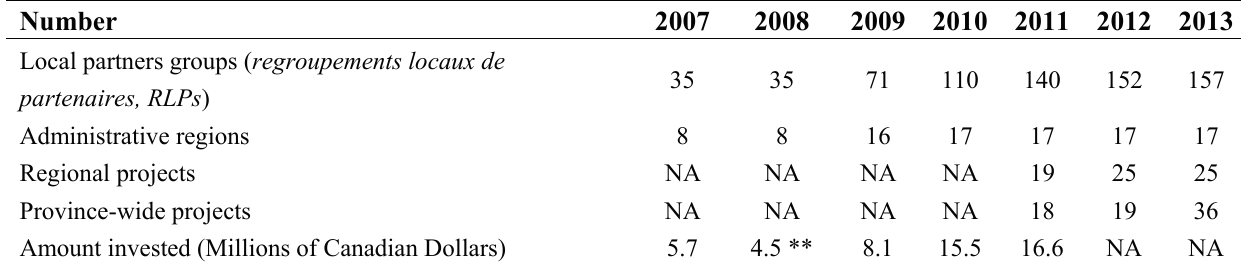
Table 1. Québec en forme (QeF) Partnerships, 2007–2013